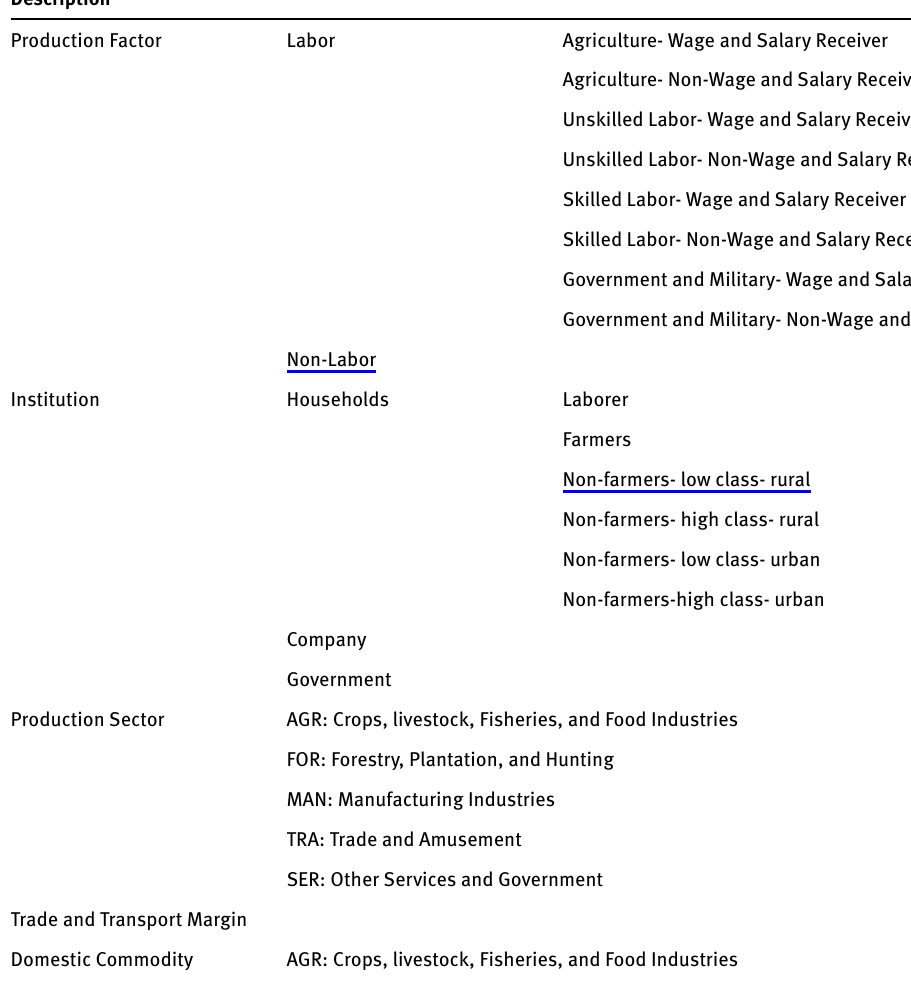
Table A1: SAM 36x36 classification Description Production